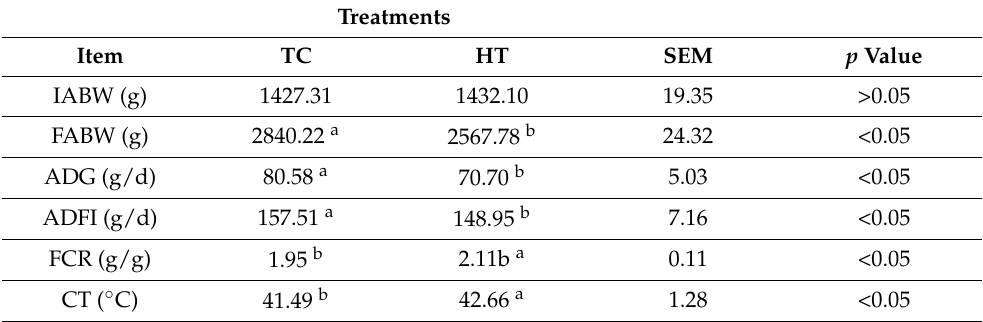
Table 2. Effects of thermal environment on performance indices of broilers during experiment